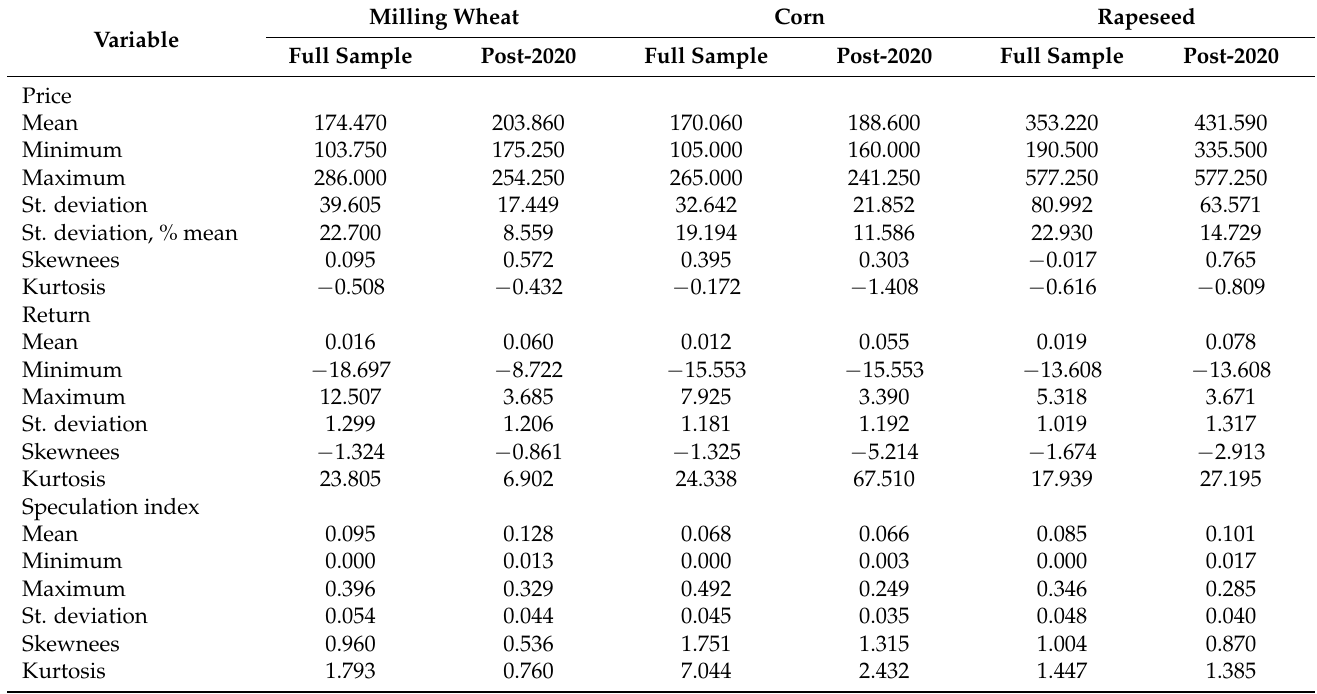
Table 1. Descriptive statistics of agricultural commodity